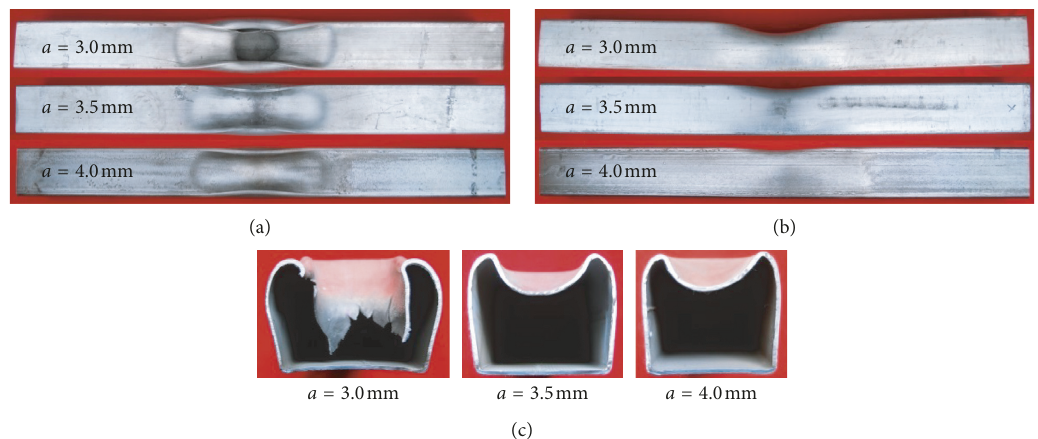
F IGURE 16: Damage of square tubes with different thicknesses at a stand-off distance of 16cm. (a) Planform view. (b) Side view. (c) Cross